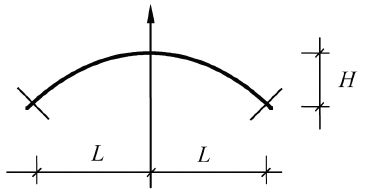
Fig. 3. Hinged-clamped Catenary arch